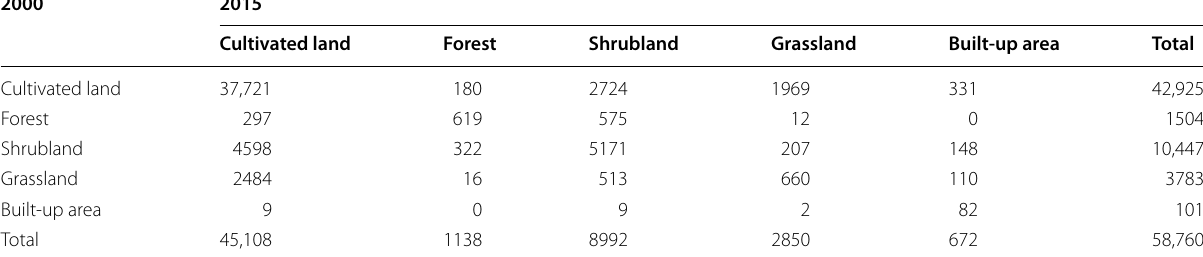
Table 8 Transition area matrix (ha) for the period 2000 and 2015